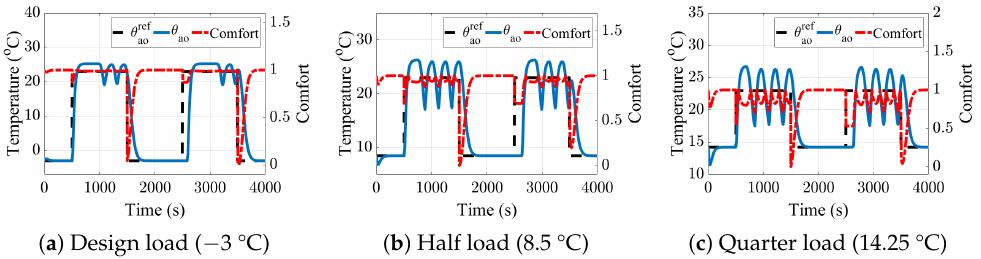
Figure 5. AHU plant response with H ∞ controller at three different thermal load conditions (square wave input).